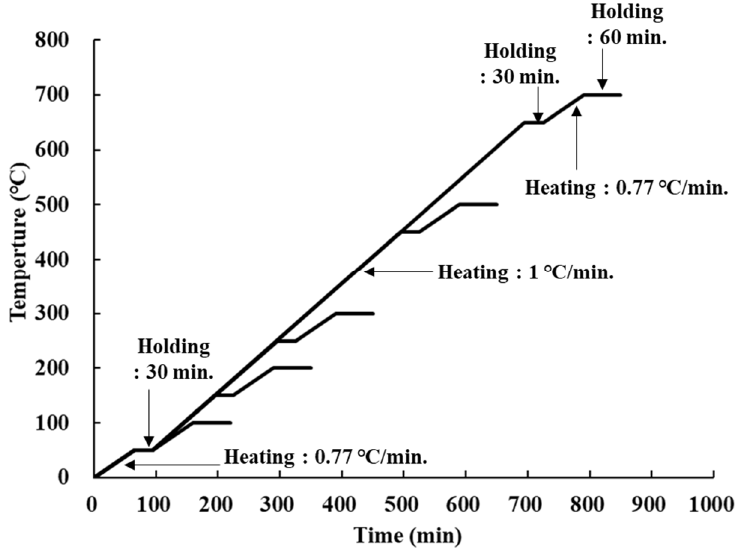
Figure 4. Heating